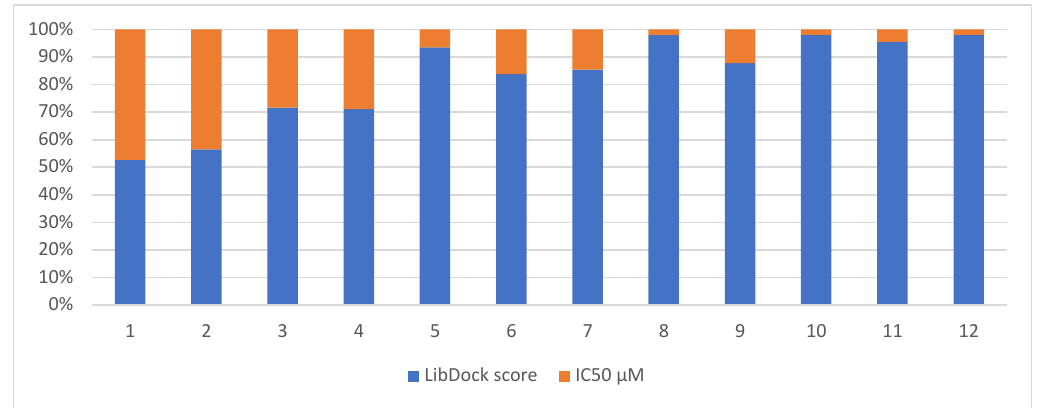
Figure 4. Column chart representation of the correlation between the LibDock score and the in vitro IC 50 values as reported in Table 1.